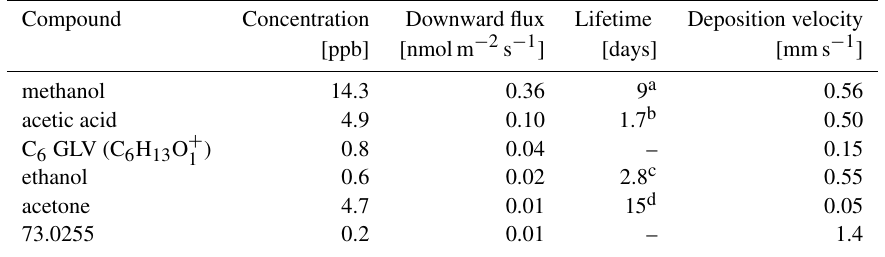
Table 3. Compounds with downward flux, their daily averaged concentration, daily averaged downward flux, deposition velocity and respec- tive lifetimes.